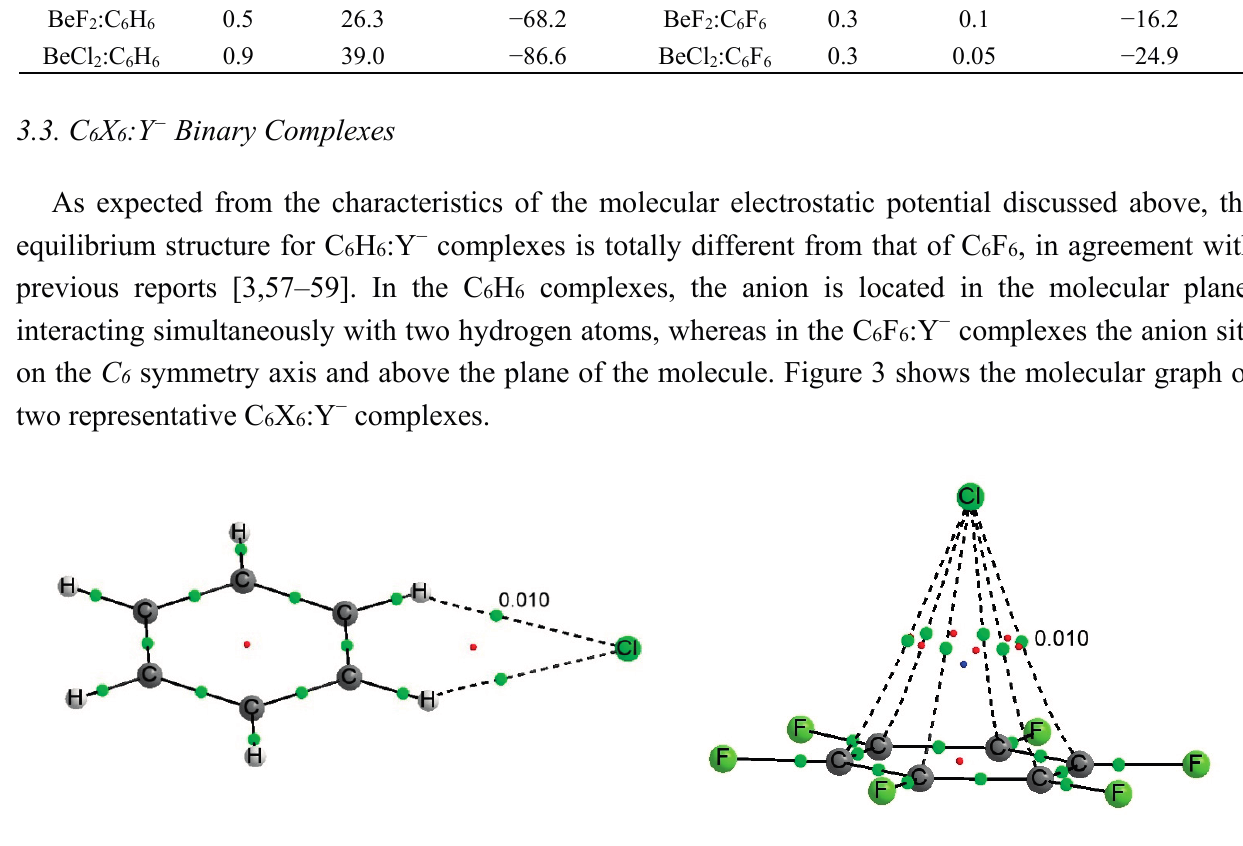
Figure 3. Molecular graph of the C 6 H 6 :Cl − ( left ) and C 6 F 6 :Cl − ( right ) complexes. Green, red and blue dots denote BCPs, ring and cage critical points respectively. The value of the electron density at the intermolecular BCP is